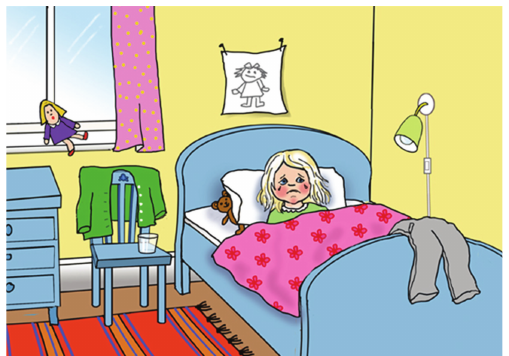
Figure 4: Sara feels ill and has to stay in bed. Illustrations by Gunilla